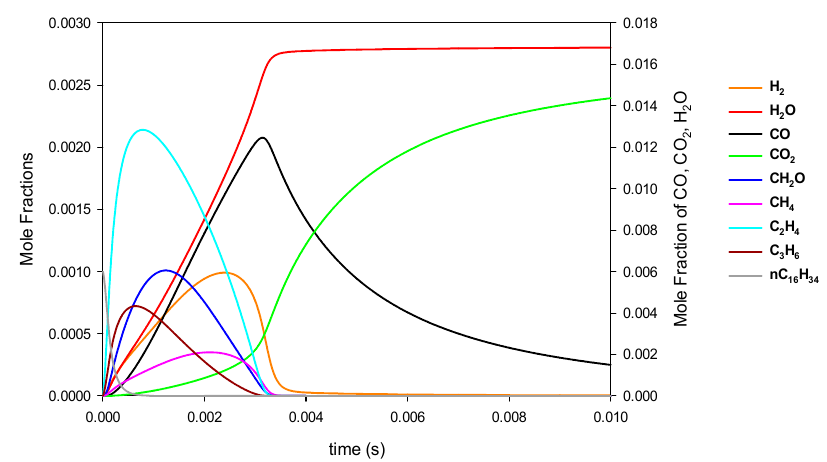
Figure 7. Combustion of 0.1% n-hexadecane at 1200K with 20% oxygen.